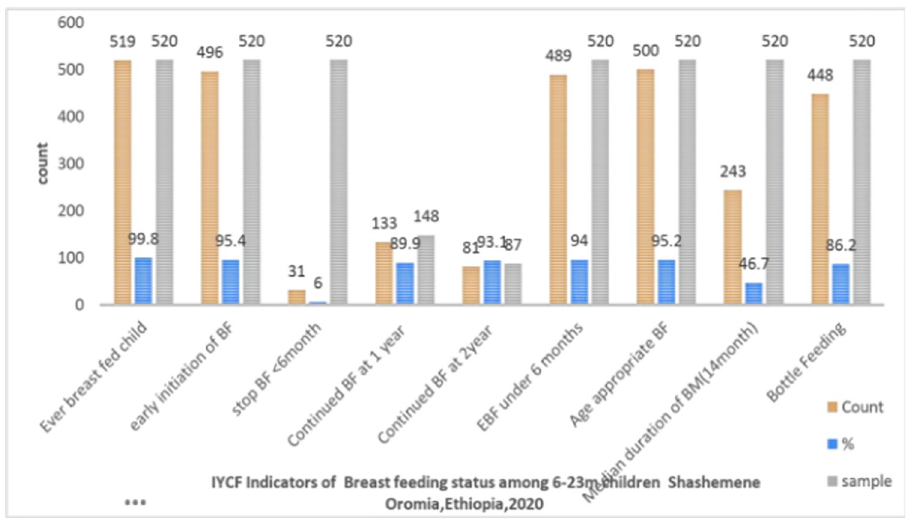
Fig 3. Indicator of breast feeding status among 6–23 month age children in Shashemene Oromia, Ethiopia, 2020. BF: Breast feeding, IYCF: Infant and young child feeding, BM: breast milk, EBF: exclusive breast feeding.